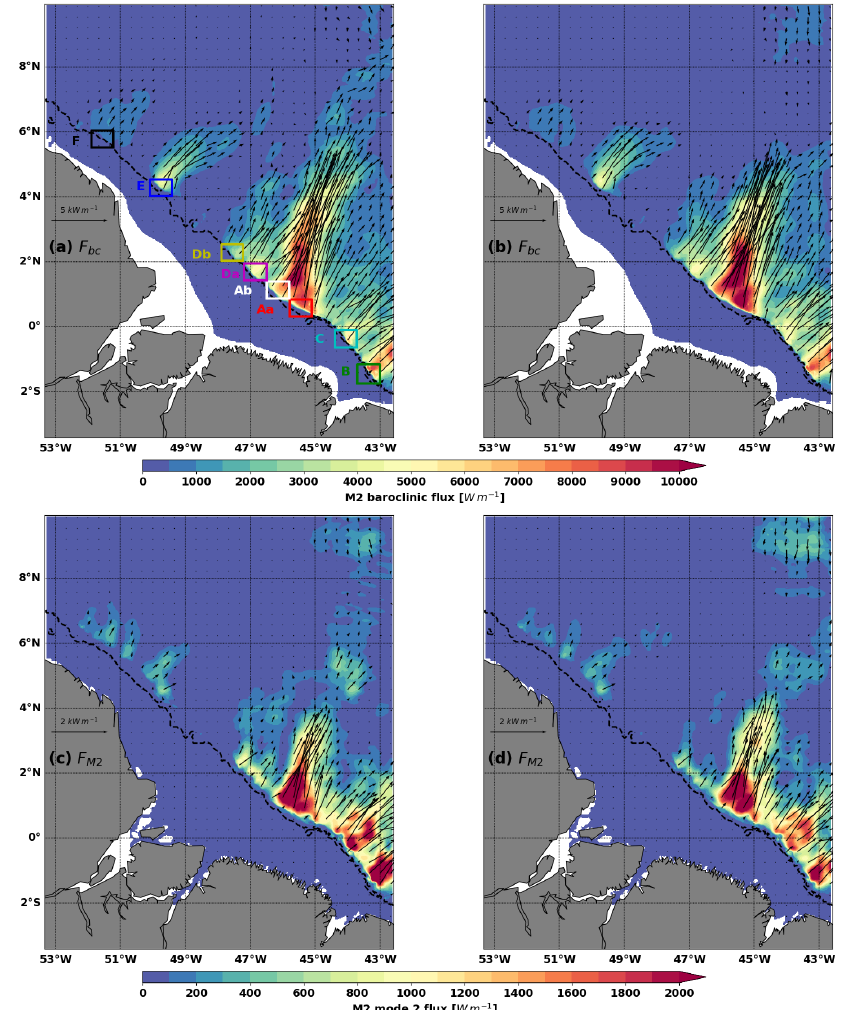
Figure 7. M2 total (a, b) and mode 2 (b, d) baroclinic flux ( F bc , colours and arrows, units: Wm − 1 ). Left column is for MAMJJ (a, c) and right column is for ASOND (b, d) . Dashed black contours are 100 and 2000m isobaths. Boxes delimit eight hotspots of internal tide